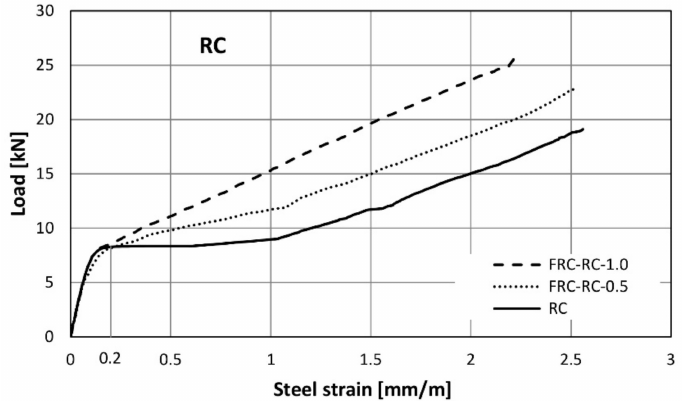
Figure 19. Strain in bottom steel reinforcement in RC/FRC-RC